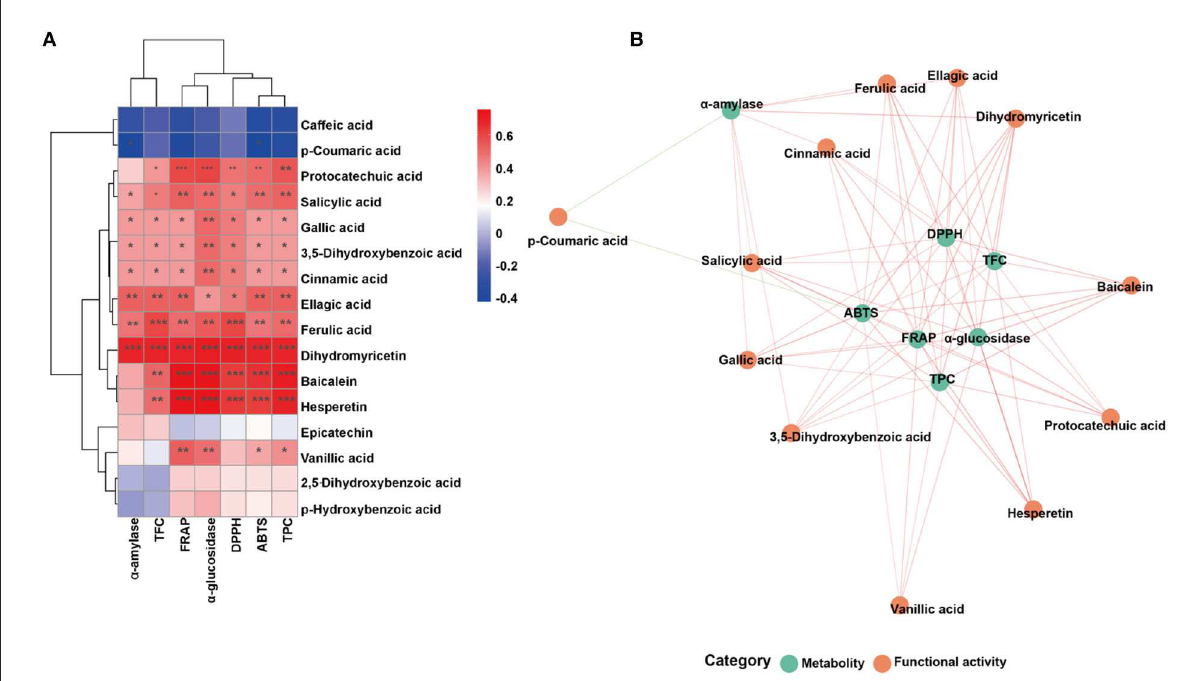
FIGURE6 Associated network diagram and correlation heat map of spearman’s analysis shows the correlation between metabolites and functional activities. (A) Associated network of FJR. (B) Correlation heat map of spearman’s analysis of FJR. Red lines represent positive correlations while green lines represent negative correlations between metabolites (green circle) and functional activities (red circle). * p < 0.05, ** p ≤ 0.01, and *** p ≤